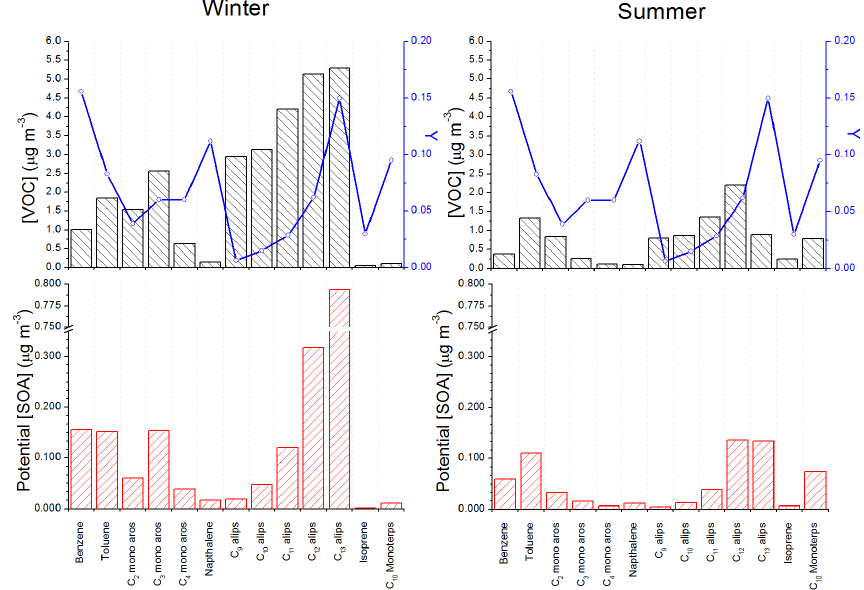
Figure 8. Potential SOA mass estimates. Upper: mean VOC mass concentration [VOC] shown by black columns, and the corresponding SOA yields ( Y ) for the VOC precursors in blue circles. Lower: potential SOA mass concentration [SOA], calculated as the product of mean VOC mass and SOA yields. Winter shown on left and summer shown on right hand side